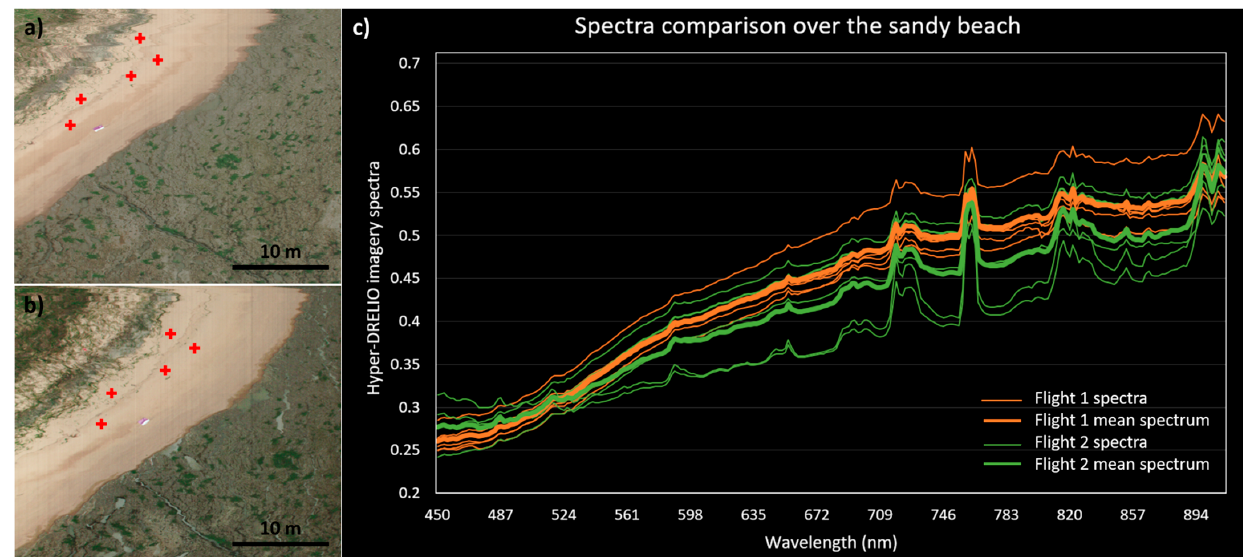
Figure 8. Spectra comparison above the supra-tidal sandy beach. ( a , b ) Sandy beach on the Hyper-DRELIO images (in natural colours) where the spectra are pointed (red crosses). The images were acquired on 12 September 2018 at 11:08 (Flight 1) ( a ) and on 12 September 2018 at 13:14 (Flight 2) ( b ). ( c ) Sand spectra extracted from Hyper-DRELIO imagery for Flight 1 (orange colour) and Flight 2 (green colour). The mean spectrum for each data set is depicted in bold.